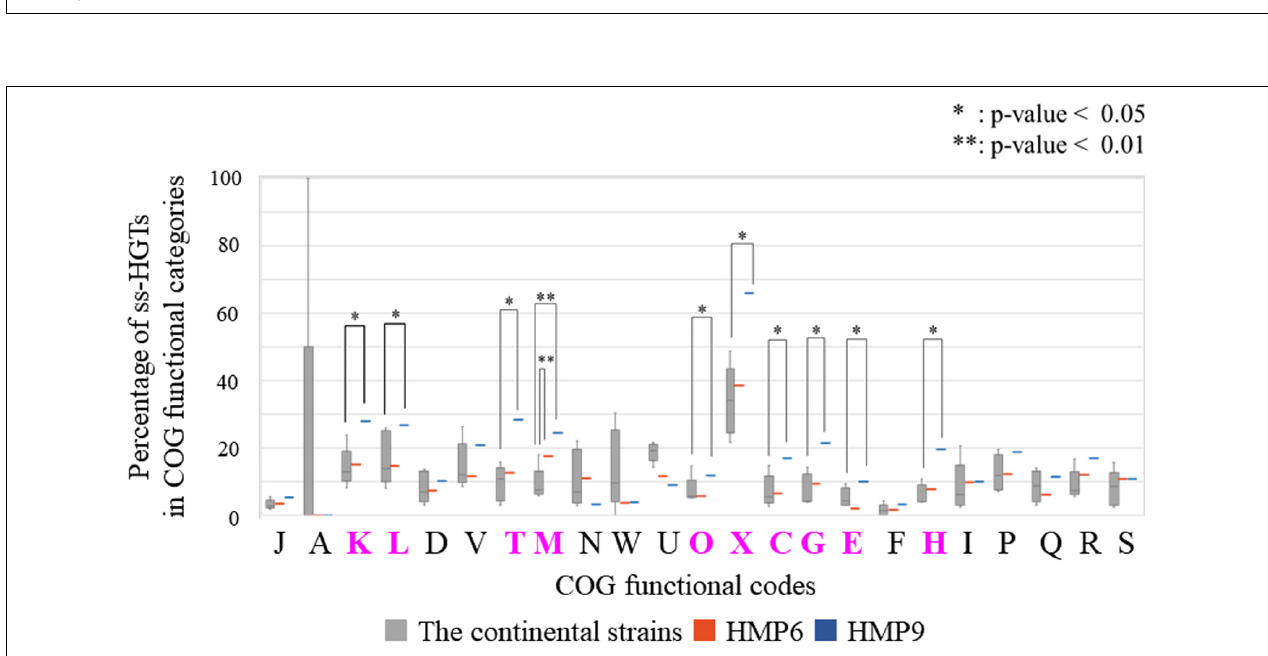
FIGURE 7 | Percentage of the strain-specific HGT candidates (ss-HGTs) per COG functional category in the continental and HMP6 and HMP9 strains. Gray ( (cid:4) ): continental strains; orange bar ( (cid:4) ): HMP6 strain; blue bar ( (cid:4) ): HMP9 strain. Asterisks: significant difference between continental and Antarctic strains. Pink functional categories represent those with significant differences between the continental and Antarctic HMP6 or HMP9 strains.